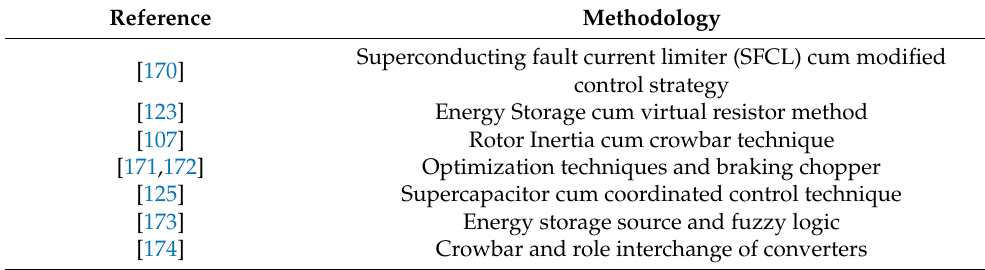
Table 3. PMSG hybrid LVRT solutions.